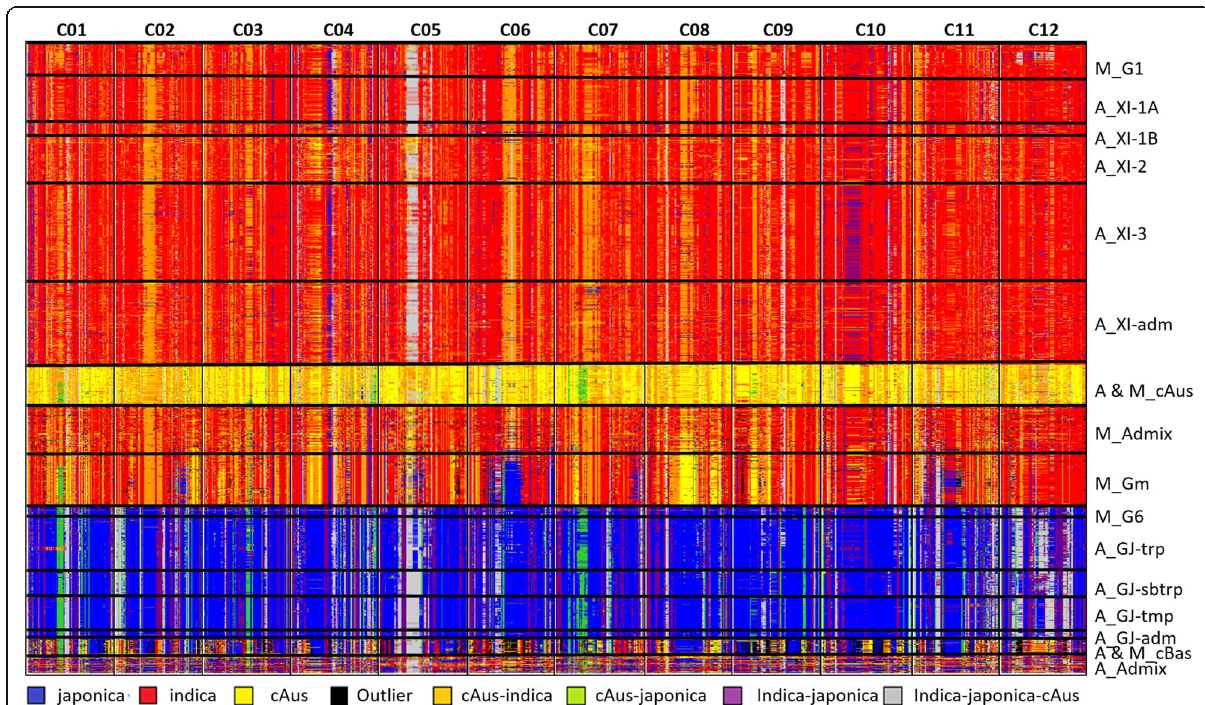
Fig. 4 Ideogram of local classification of the genomes of 1929 Asian and 620 Malagasy rice landraces, based on 23,982 SNP. Patterns are organised per chromosome from left to right and by accessions from top to bottom. The Asian accessions (prefix A) are organised first by their classification in Wang et al. (2018) groups and subgroups, then by alphabetic order of country (not shown). Malagasy accessions (prefix M) are organised first by groups identified by structure analysis with K = 3, then by increasing values of ancestry